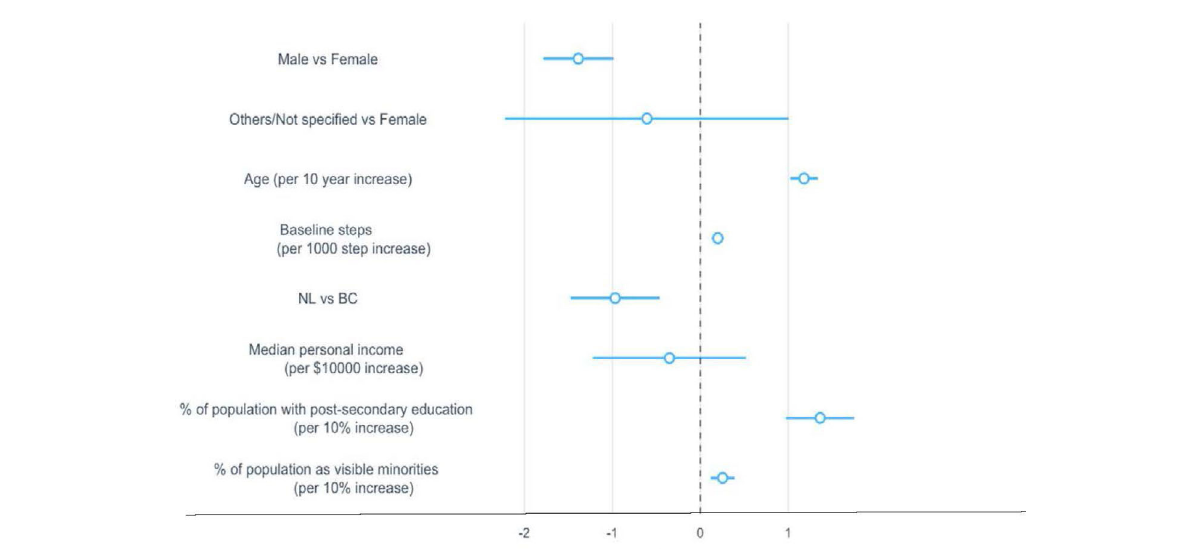
FIGURE4 Regression coefficients and 95% confidence intervals for sociodemographic correlates associated with duration of use. The dotted vertical line indicates a mean difference of zero, which means a correlate neither increased nor decreased the duration of use. BC, British Columbia; NL, Newfoundland and